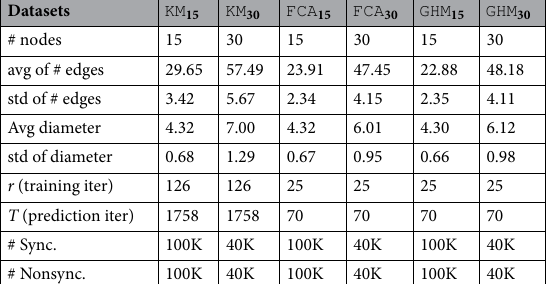
Table 2. Dynamics datasets were generated for three models with two node counts. In each dataset, all graphs are connected and non-isomorphic. # Sync. denotes the number of examples in the dataset such that the phase configuration X T at iteration T is concentrated.